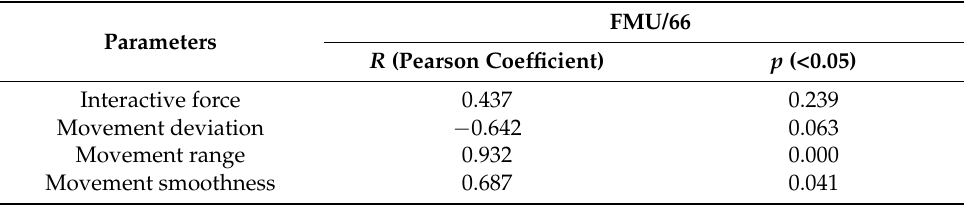
Table 3. Correlation between robot-based indicators and clinical